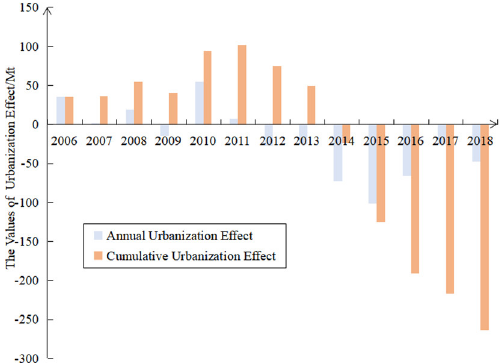
Figure 3. Annual and cumulative urbanization effect of the YREB [source: own illustration].